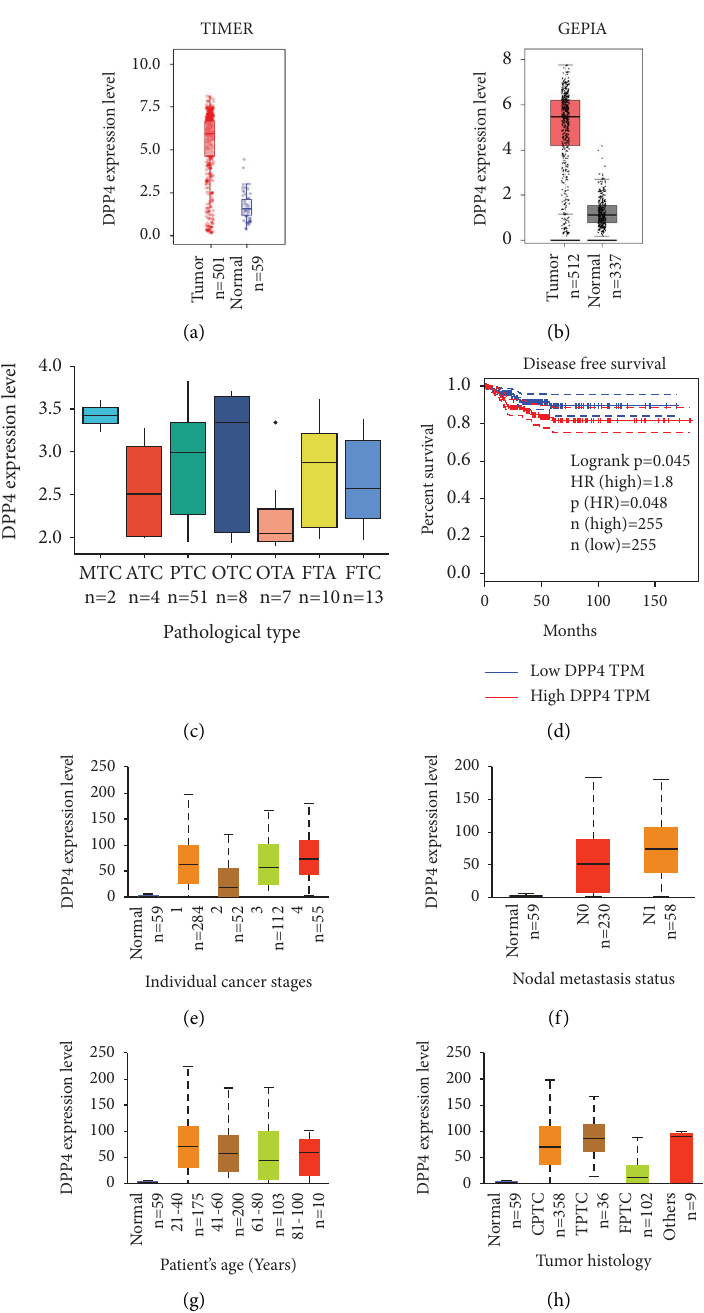
Figure 1: Te diferential expression of DPP4 and its efect on prognosis in THCA. (a) Te analysis result from TIMER: the mRNA expression level of DPP4 in THCA is statistically higher than that in normal thyroid tissues ( p < 0 . 001). (b) Te result from GEPIA is consistent with that of A ( p < 0 . 01). (c) Expression of DPP4 at the mRNA level in 7 diferent pathological types of thyroid nodules ( p > 0 . 05). (d) DPP4 expression signifcantly afects DFS of THCA patients ( p � 0 . 048). (e) DPP4 expression is diferent in patients with diferent clinical stages of THCA, Stage 2 vs. Stage 3 ( p < 0 . 01), and Stage 2 vs. Stage 4 ( p < 0 . 001). (f) DPP4 expression is diferent in THCA patients with diferent lymph node metastatic status, N0 vs N1 ( p < 0 . 05). (g) DPP4 expression is diferent in diferent age groups of THCA patients, Age (21–40 Years) vs. Age (41–60 Years) ( p < 0 . 05), and Age (21–40 Years) vs. Age (61–80 Years) ( p < 0 . 01). (h) Tere are diferences in DPP4 expression among THCA patients with diferent histological subtypes, CPTC vs. TPTC ( p < 0 . 05), CPTC vs. FPTC ( p < 0 . 001), and TPTC vs. FPTC ( p < 0 .